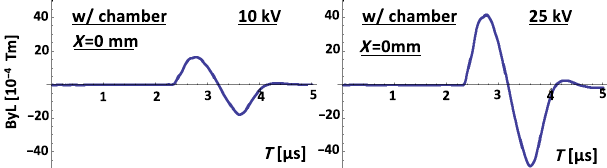
FIG. 5. The dependence of the eddy-current magnetic field on the supplied